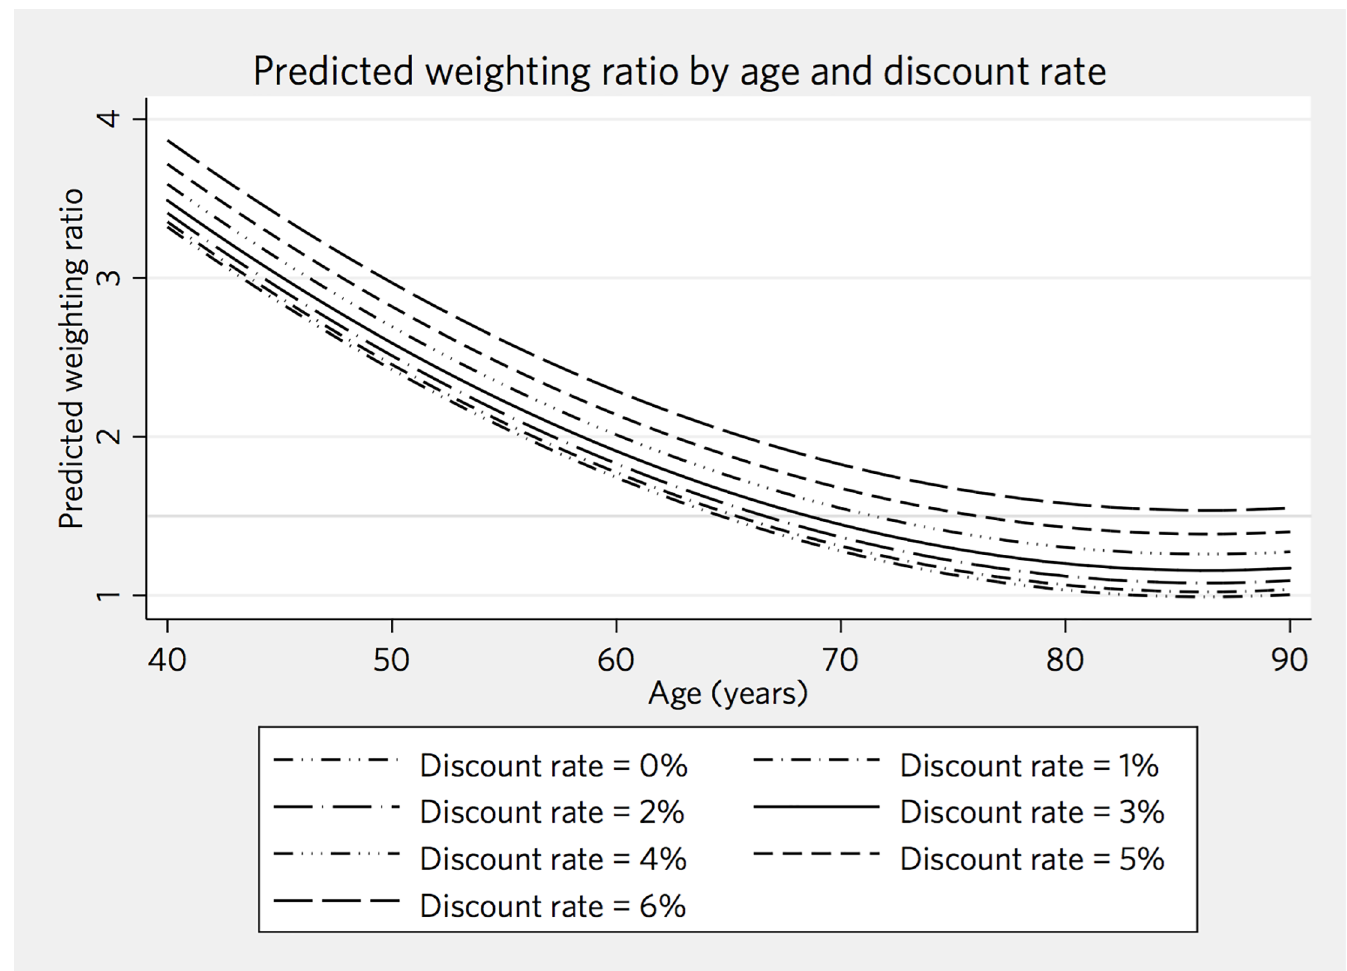
Fig 2. Predicted marginal weighting ratio, as a function of age.